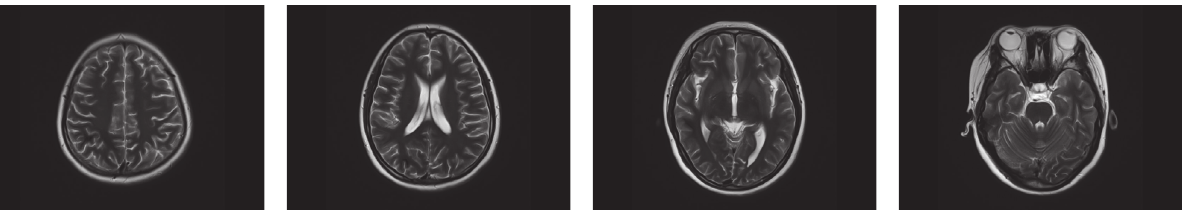
Figure 4: Approximately 6 weeks after initial treatment with